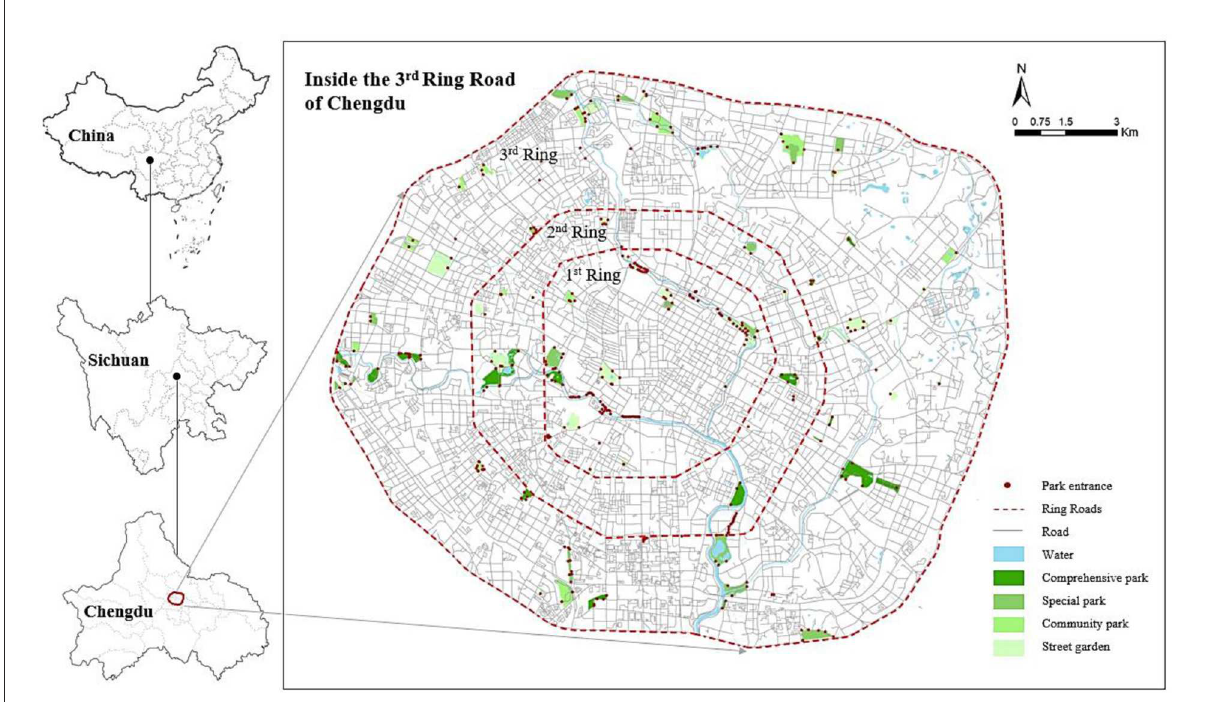
FIGURE3 Location of the study area in Chengdu and spatial distribution of research subjects.